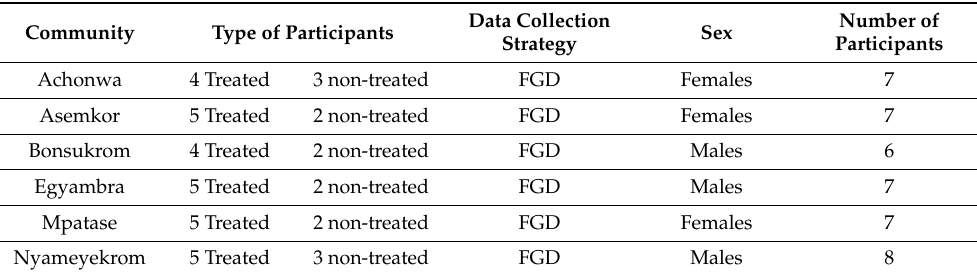
Table 2. Socio-demographic characteristic of qualitative study